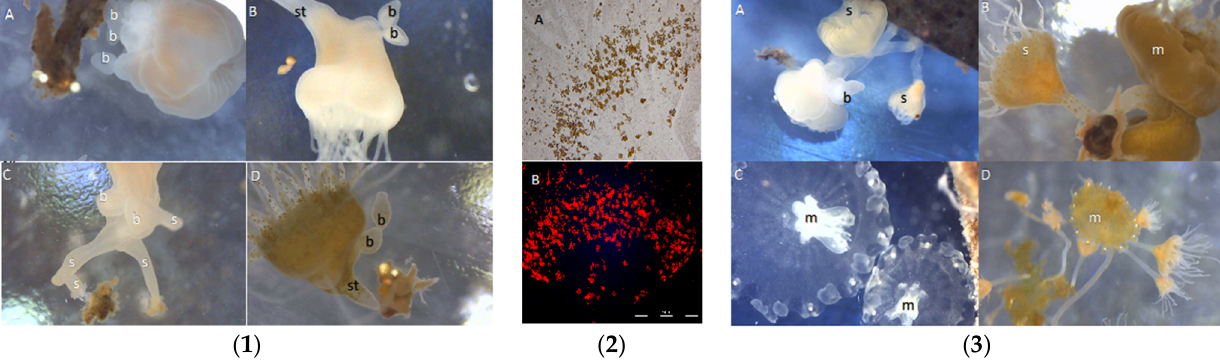
Figure 7. ( 1 ) Scyphistomae of C. frondosa ( A , C ) and C. xamachana ( B , D ). C. frondosa has asymmetrical buds (b) and often times multiple stolons (s) ending in attachment of large polyps, whereas C. xamachana has symmetrical buds (b) and one attachment at end of the stalk (st). ( 2 ) Symbiotic algae in digestive cells and amebocytes in scyphistomae of C. xamachana in ( A ) incandescent and ( B ) epiflourescent light. Symbionts are about 10 μm in diameter. ( 3 ) Strobilating scyphistomae (s) and medusae (m) of C. frondosa ( A , C ) and C. xamachana ( B , D ). b = bud, bright white dots around the edge of medusa are